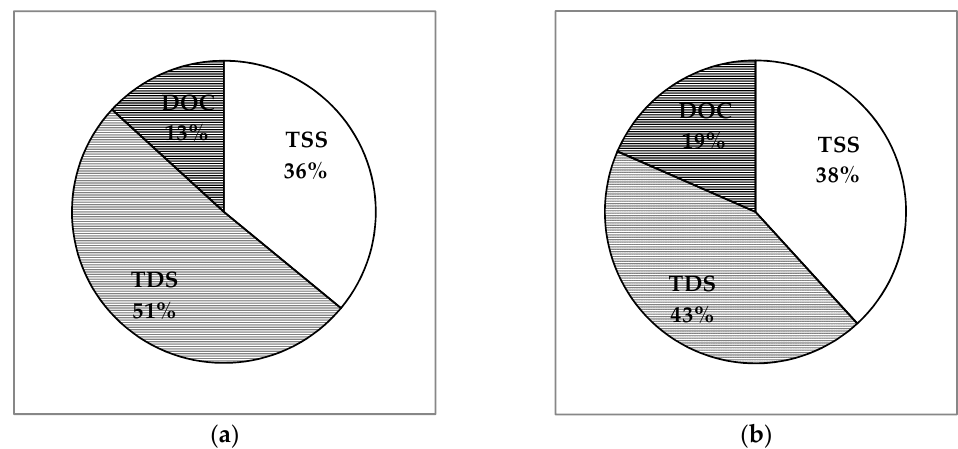
Figure 7. Percentage contribution in fluxes of total suspended sediment (TSS), total dissolved solid (TDS), and dissolved organic carbon (DOC) of the total matter fluxes transported by the Congo River at its mouth outlet for: ( a ) the 1987–1993 period, and ( b ) the 2006–2017 period.